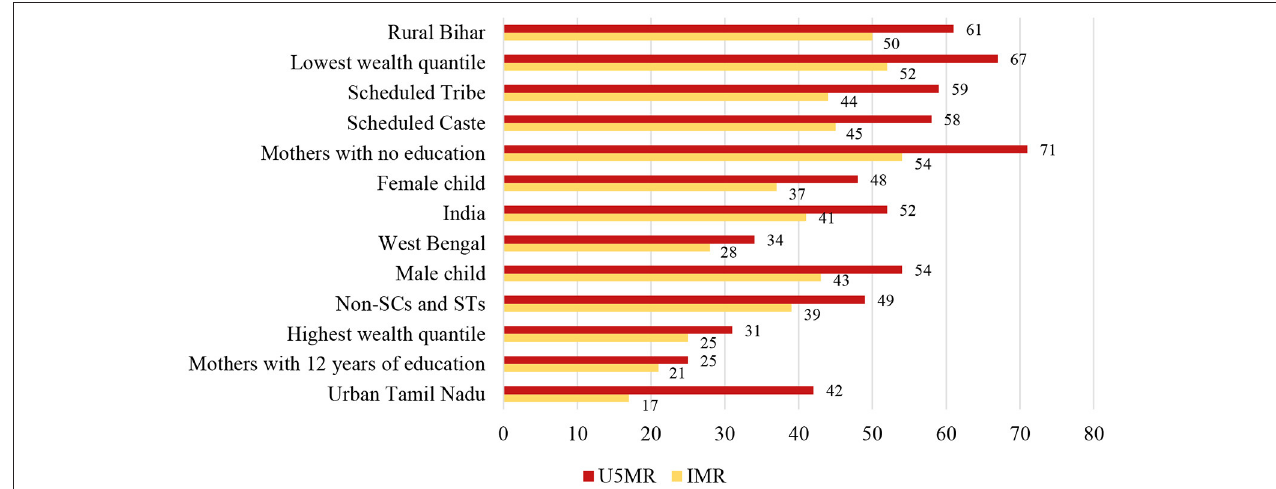
FIGURE 2 | Inequalities in infant and under-five mortality in India, 2015–2016.